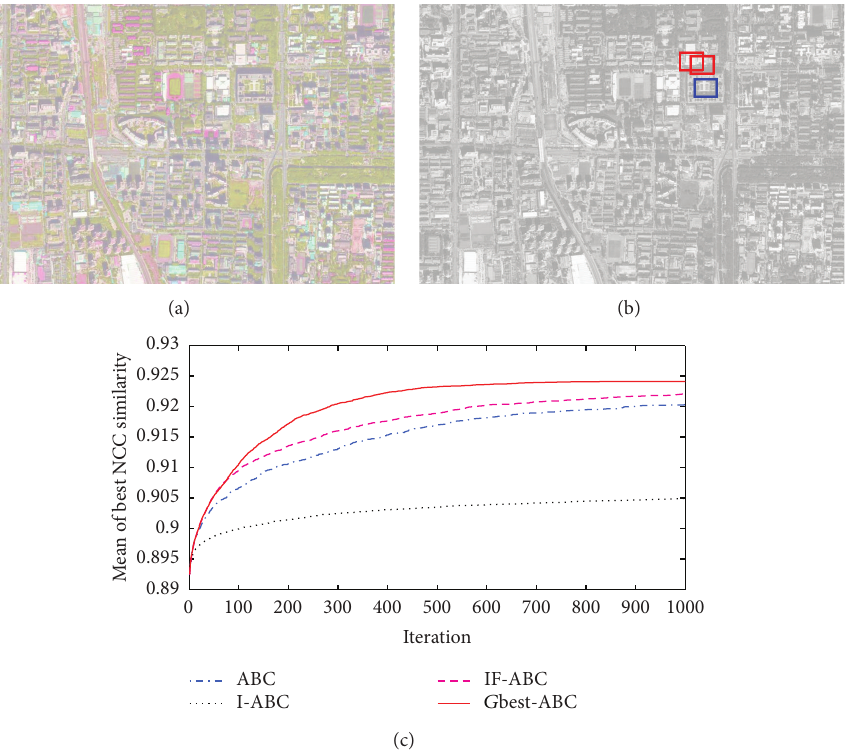
Figure 10: Practical template matching case 3. (a) Overexposed source image; (b) ground matching truth (blue box) and most common false matching results (red boxes); (c) comparative evolution curves of four ABC